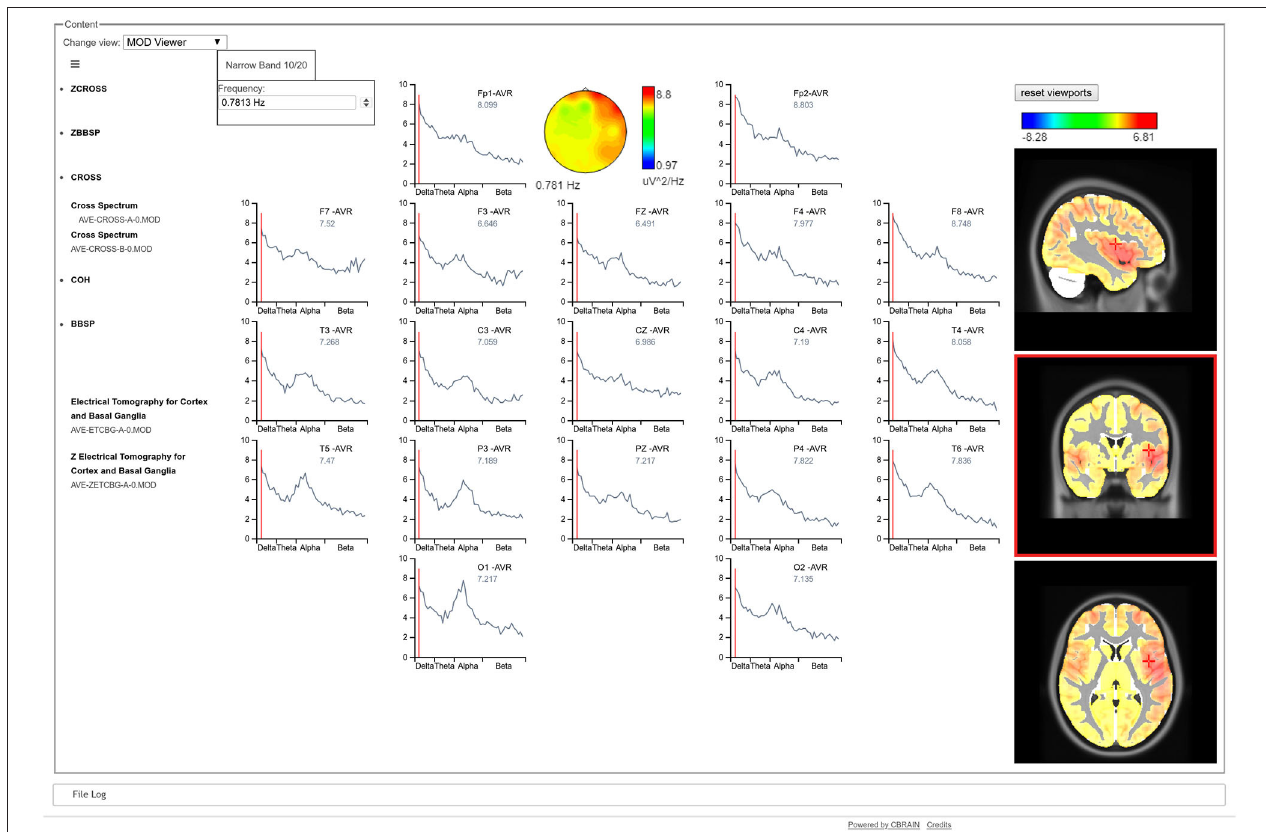
FIGURE 1 | CBRAIN qEEGt visualization tool. The results of a qEEGt session are shown: the raw EEG spectra at the scalp for each electrode. A cursor indicates the specific frequency (0.78Hz), where the spectral topographic map for all electrodes are shown. Correspondingly, the 3D tomographic view is shown for the EEG spectra at the sources for the same frequency. The red color of the topographic map at the electrodes shows an increased frontal activity, that extents to the temporal in the right hemisphere. The three views of the tomographic map show that the maximum of the activity is in the temporal pole. A similar graph can be obtained for the Z values, both at the sensors as well as at the